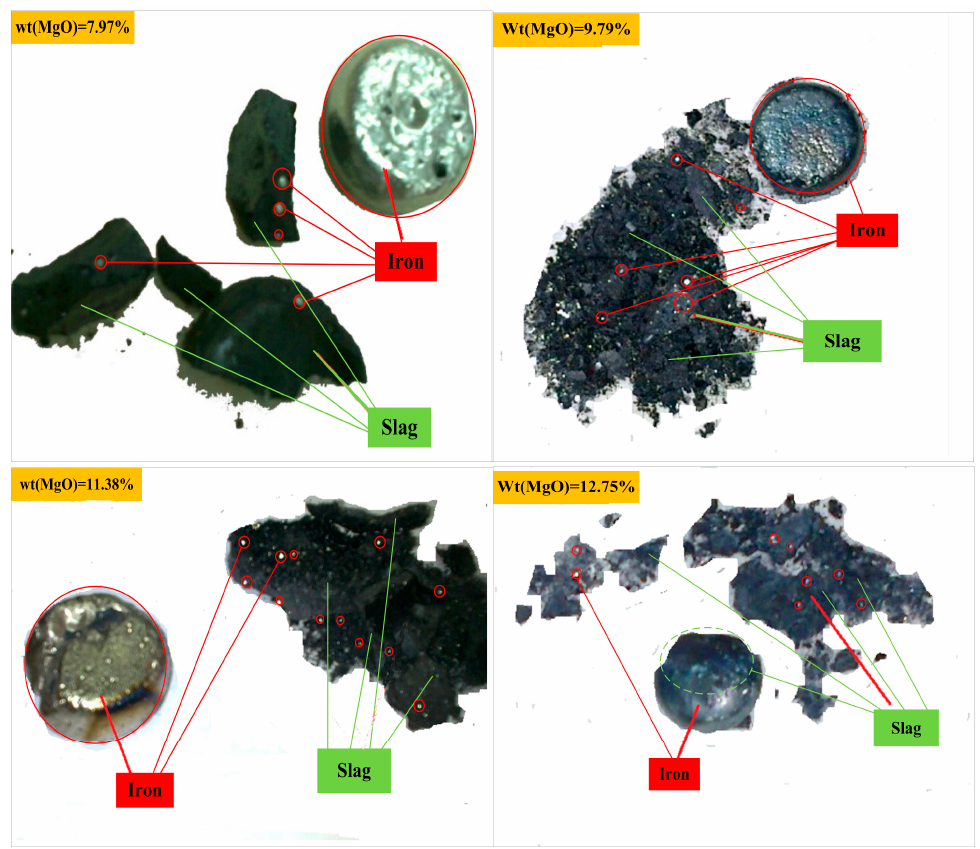
Figure 14. Separation photos of iron and slag with varying MgO content.